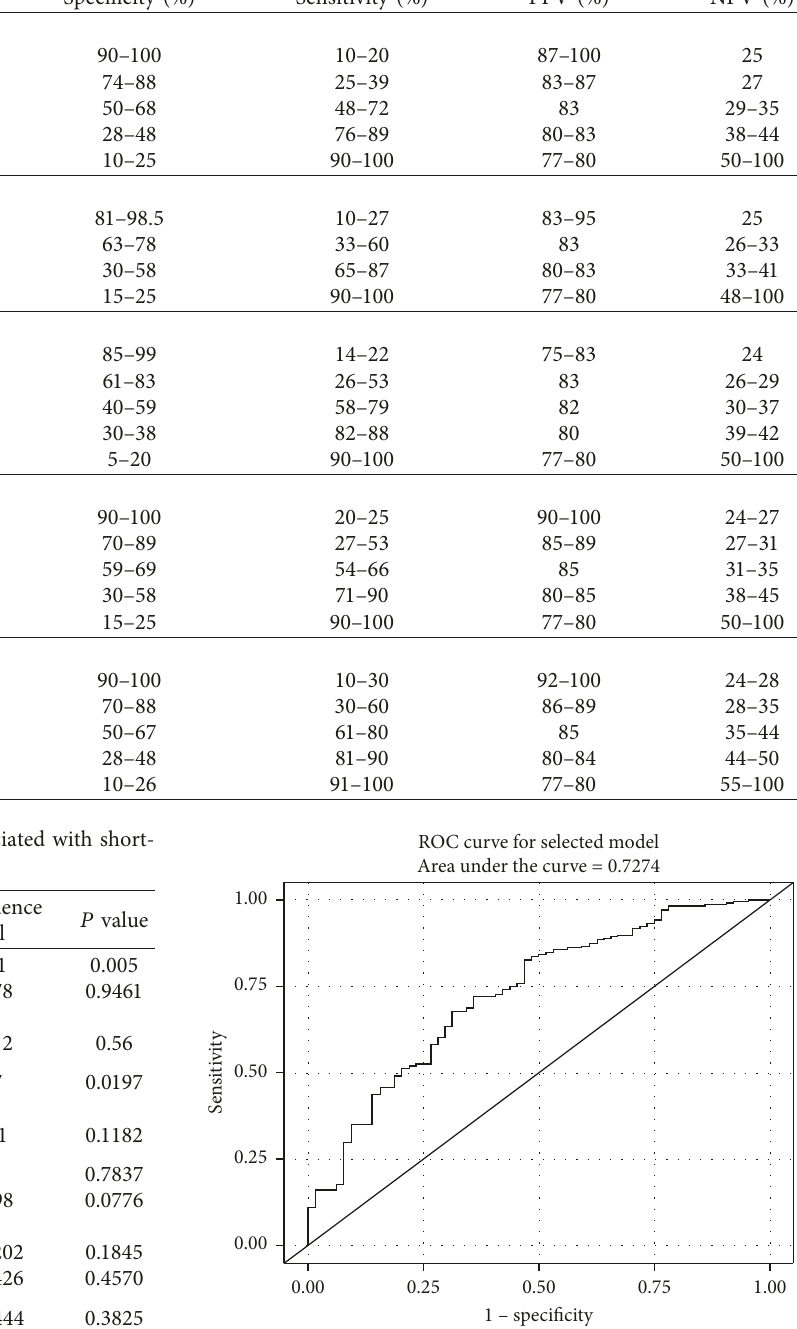
Figure 1: ROC curve analysis for predictors that were significant on multivariate regression analysis for short-term